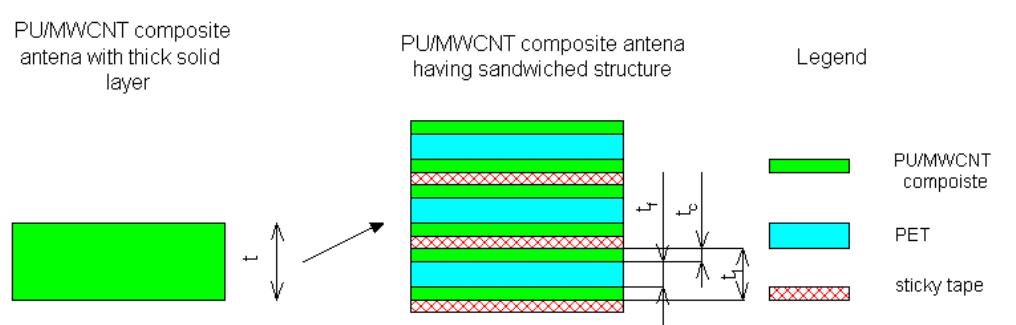
Figure 12. Detailed view of the layered structure of the polymer antenna.